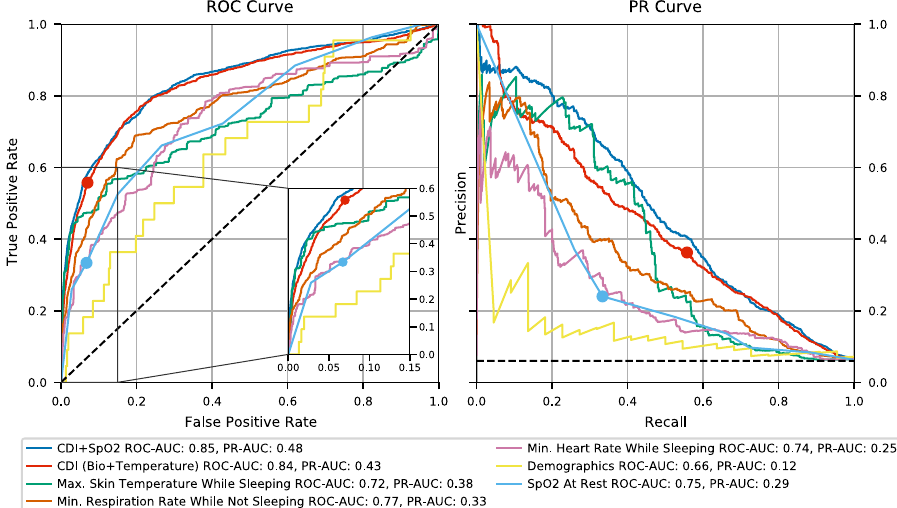
Fig. 1 ROC and PR curves for selected models and univariate signals. The PR and ROC curves are weighted for equal participant contribution. The operating threshold for CDI and the 93% O 2 threshold are marked as points on the curves.